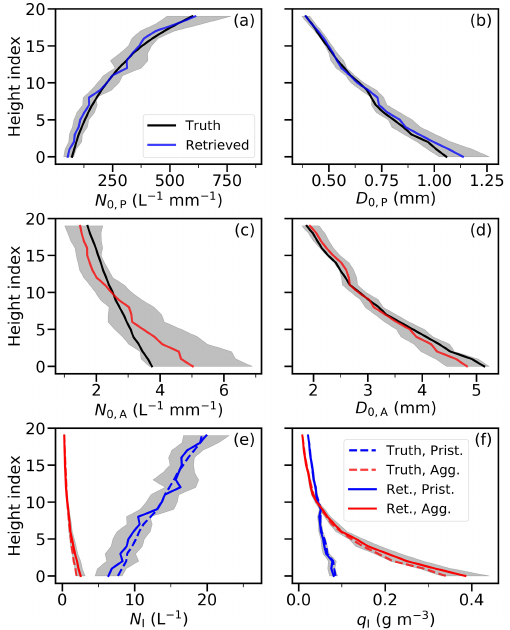
Figure 5. Profiles of (a) normalized number concentration and (b) normalization diameter for pristine ice and (c) normalized num- ber concentration and (d) normalization diameter for aggregates. Panel (e) represents the total number concentrations, and panel (f) represents ice water contents of pristine ice and aggregates. Truth is denoted by solid black lines in (a) – (d) and by dashed lines in (e) and (f) . The retrieved ensemble means are denoted by solid blue and red lines with shading that represents the 1-standard-deviation spread of the ensemble members. The habit of pristine ice is plate in this